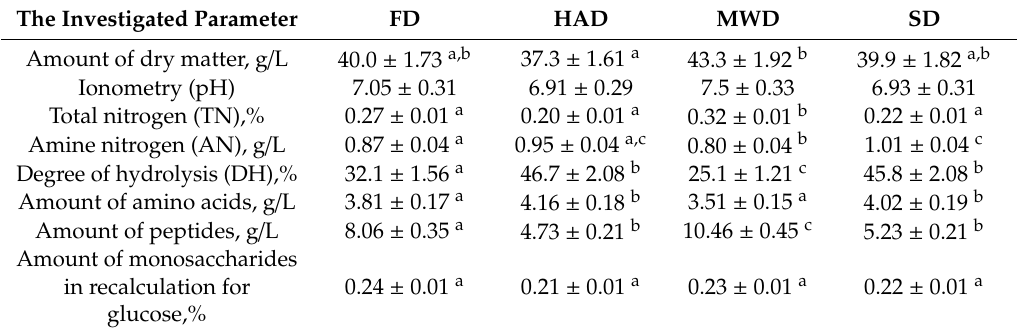
Table 2. Some physicochemical parameters of the dry fruiting bodies of Pleurotus ostreatus after in vitro